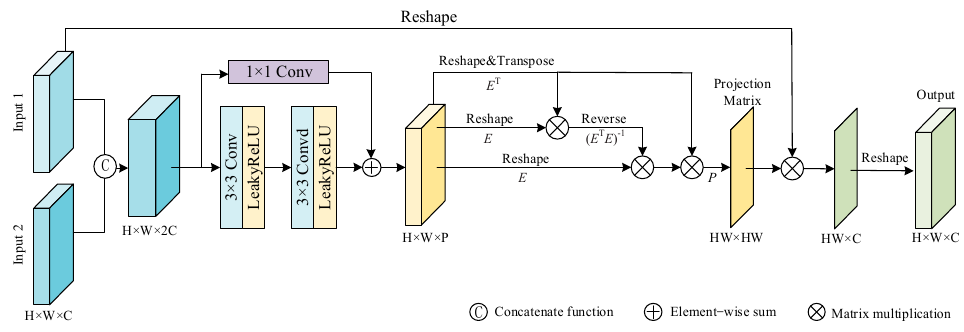
Figure 3. Details of the orthogonal subspace projection attention (OSPA) module.